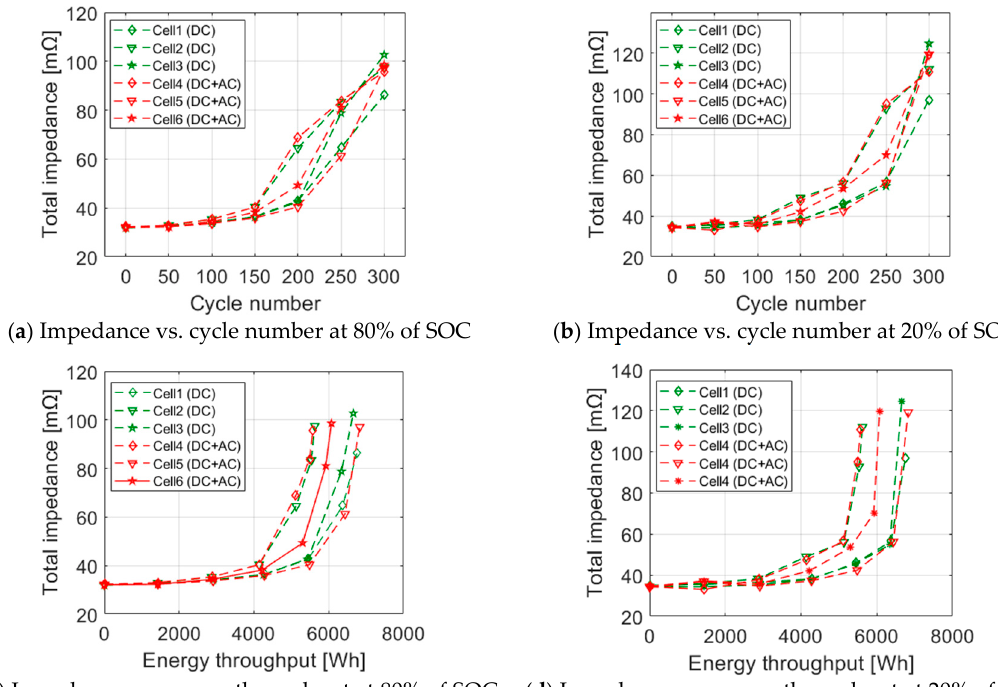
Figure 8. DC impedance increase as a function of number of cycles and total energy throughput for normal condition set group (i.e., cells 1–3) versus AC ripple condition set group (i.e., cells 4–6).